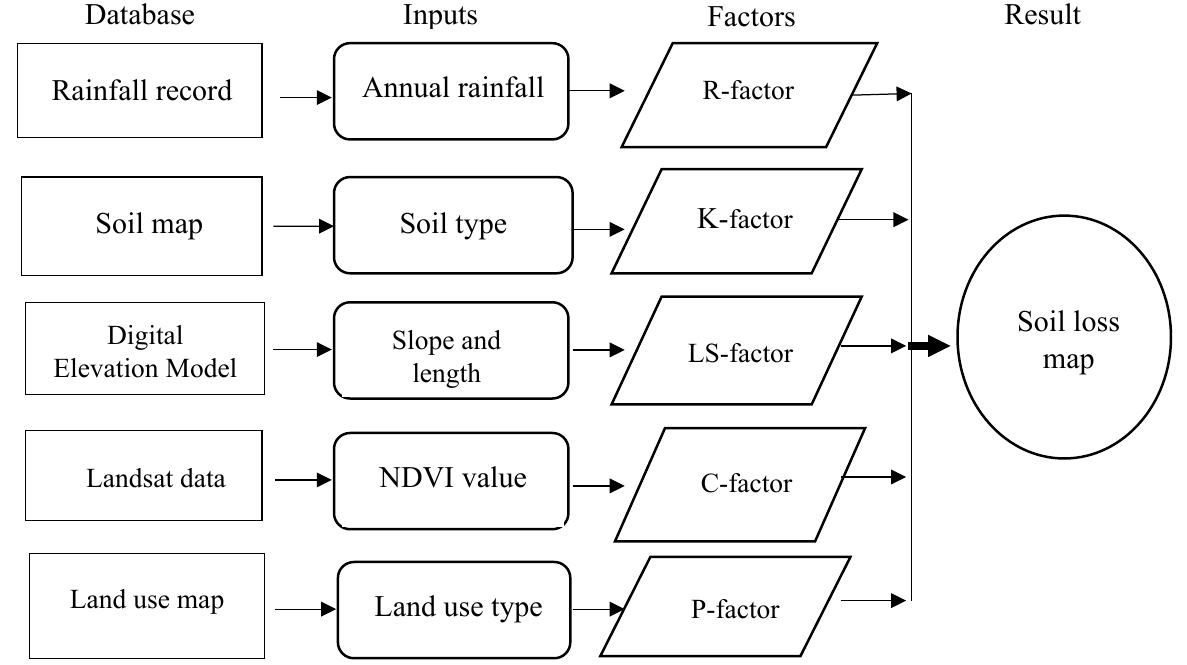
Figure 2. The methodological framework for soil erosion estimation using RUSLE